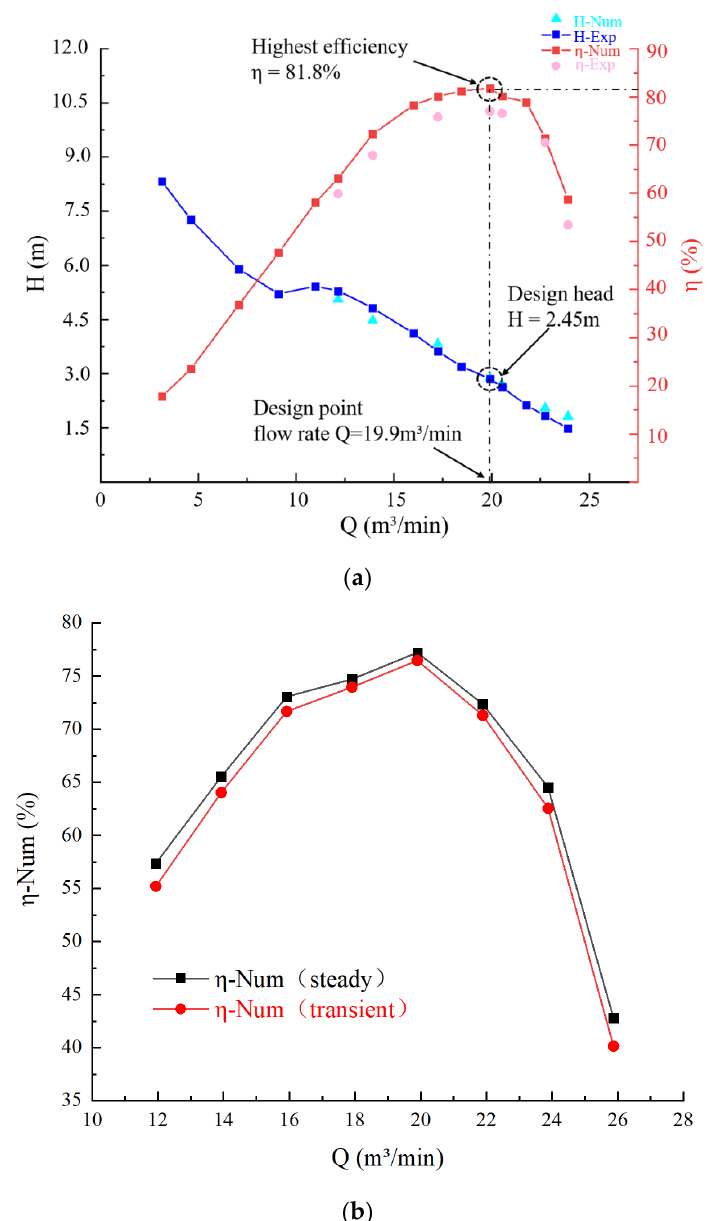
Figure 7. Comparison of numerical simulation and experimental results: ( a ) Steady numerical simulation and experimental results; ( b ) Steady and transient numerical simulation results.